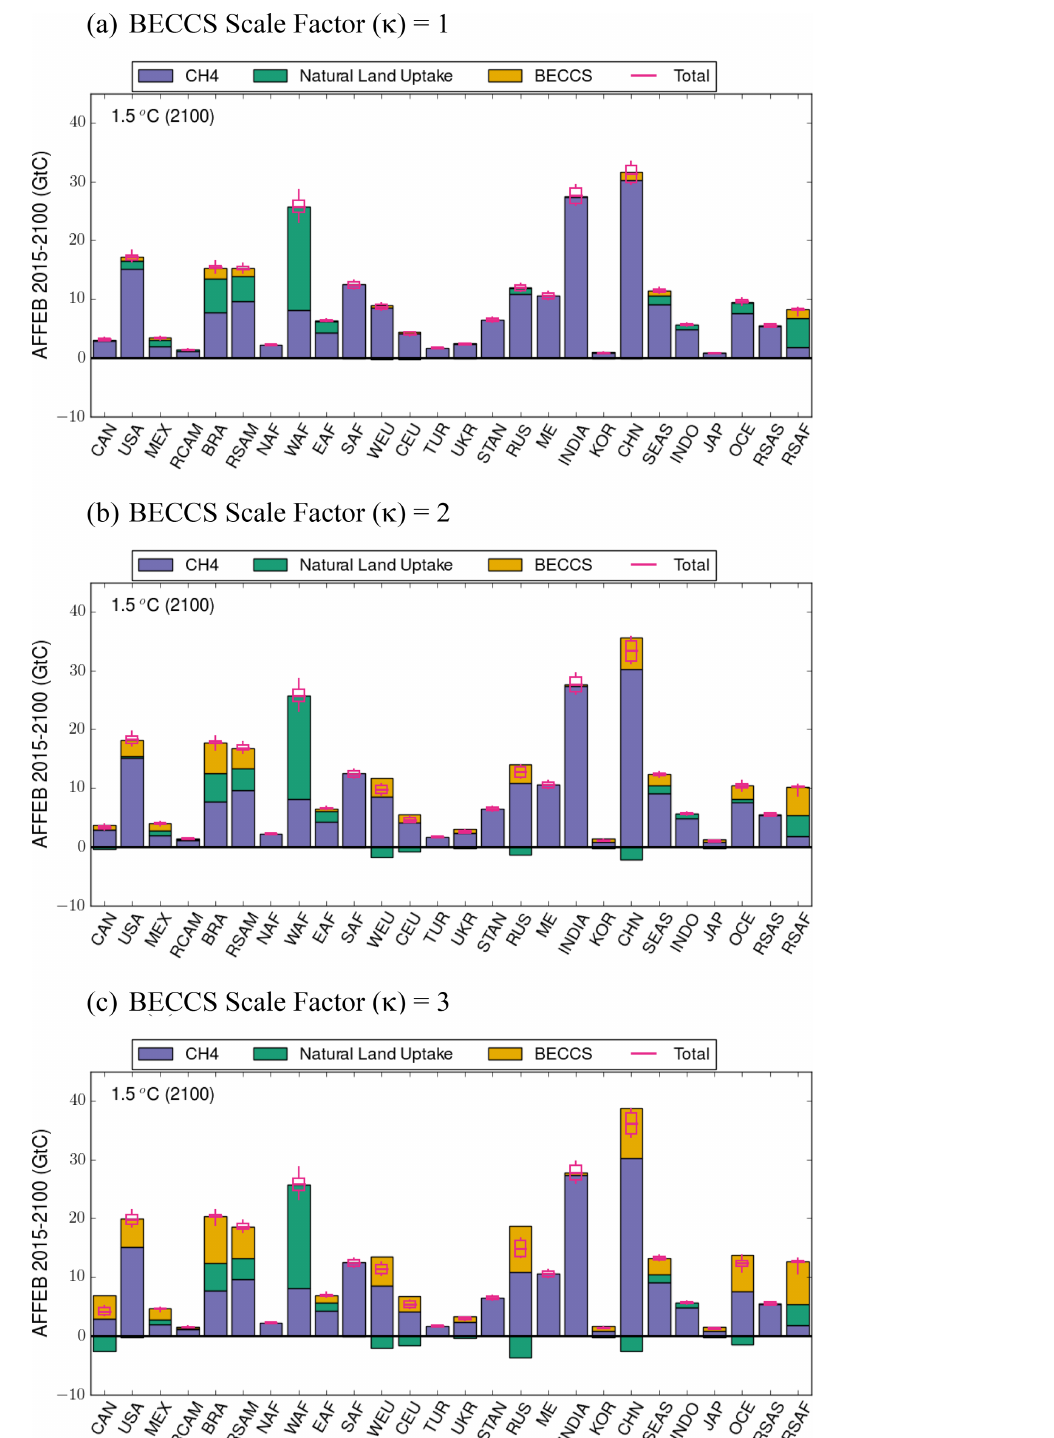
Figure 12. Contribution of different mitigation options to the increase in allowable anthropogenic fossil fuel emission budgets by IMAGE region to meet the 1.5 ◦ C target. The stacked bars represent the median methane mitigation potential (purple bars) and median land-based mitigation potential (natural land uptake, green; BECCS, brown). Panel (a) is based on a BECCS scaling factor of unity, panel (b) a BECCS scaling factor of 2, and panel (c) a BECCS scaling factor of 3. The total (pink) shows the median and interquartile range of the 136-member